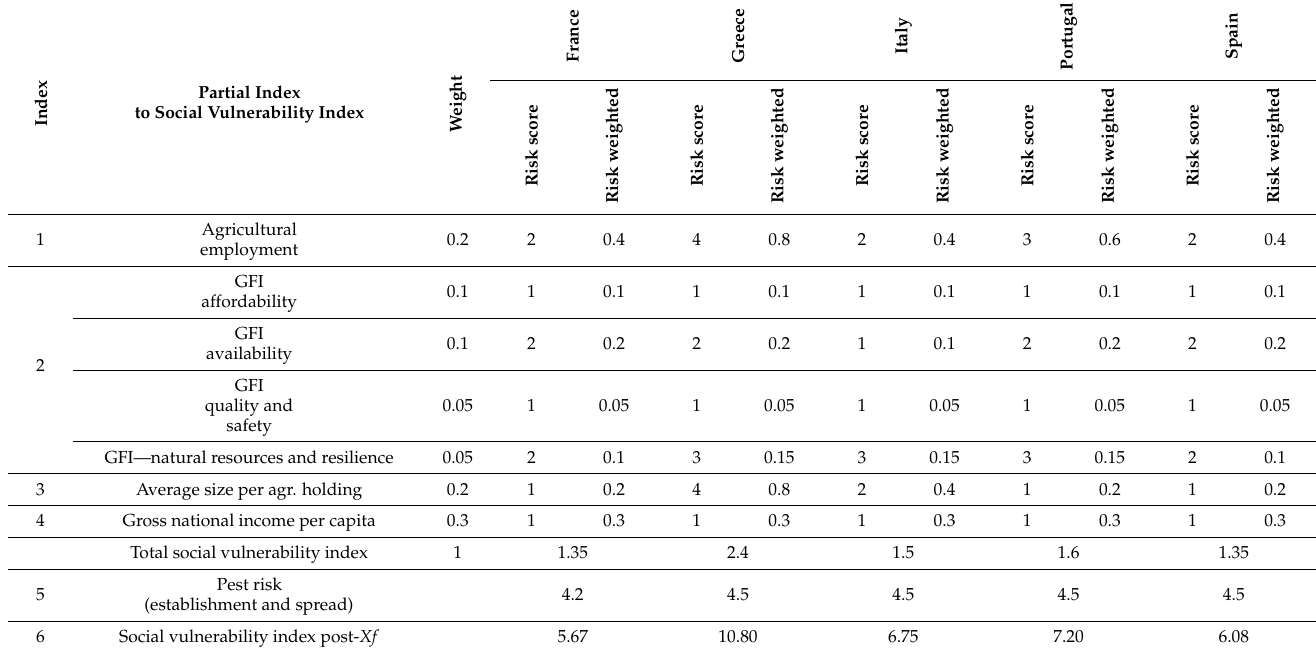
Table 6. Assessment of the social vulnerability index due to Xylella fastidiosa on olives, grapes, Citrus spp. and almonds in the European Mediterranean countries (Year: